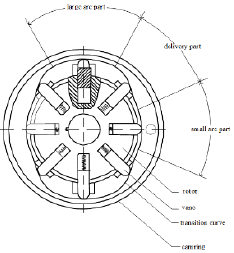
Figure 1. Vane pump cross-sectional configuration.